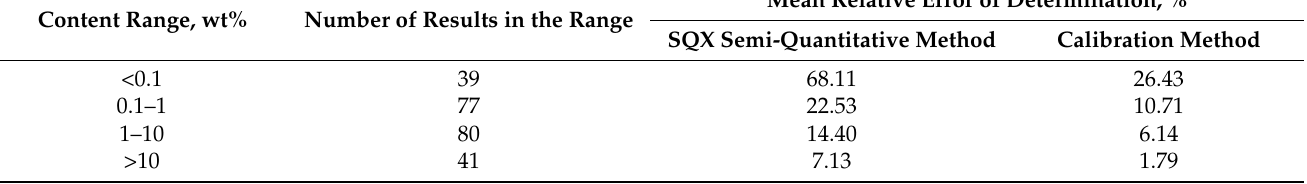
Table 11. Mean values of the relative errors for 4 content ranges in the SQX semi-quantitative method and the method based on